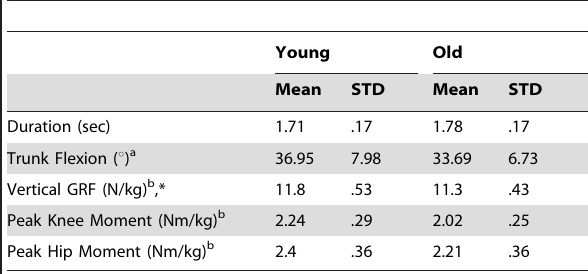
Table 2. Sit-to-stand strategy and mechanical demands in young and old